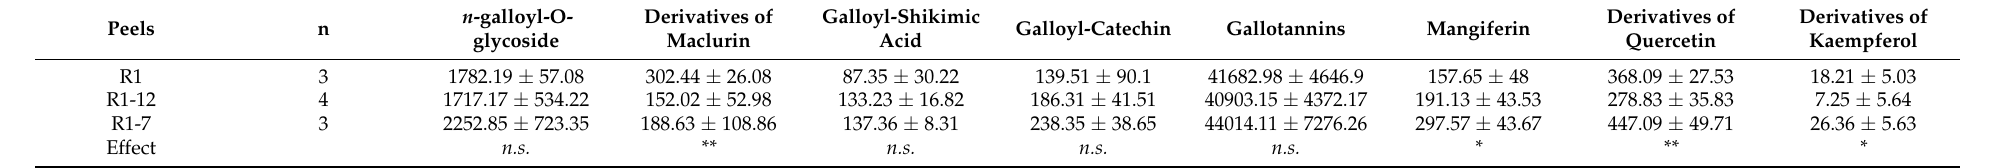
Table 4. Phenolic compound contents in the peel of ripe (“R”) cv. ‘Cogshall’ mango ( µ g g FM − 1 ) from H1 harvest depending on storage temperature. n.s., *, ** mean that the effect of storage temperature treatment is non-significant, significant at p < 0.05, and p < 0.01, respectively, for H1 harvest